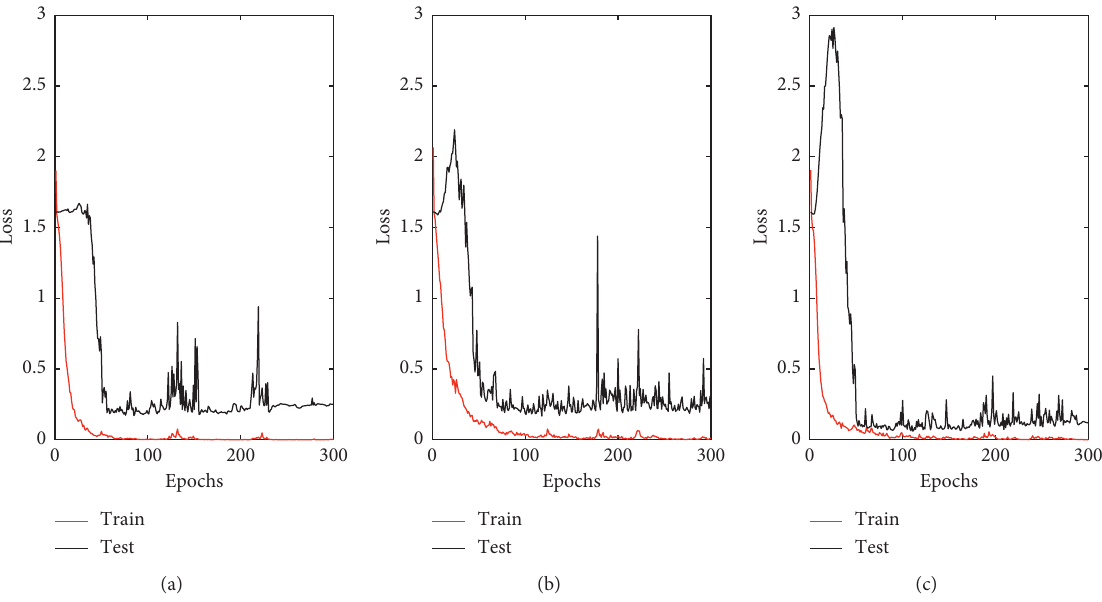
Figure 6: Loss function across epochs of CNN model: (a) upper leaf, (b) middle leaf, and (c) lower leaf. Table 5: The prediction results (%) of convolutional neural networks running 10 times. Data